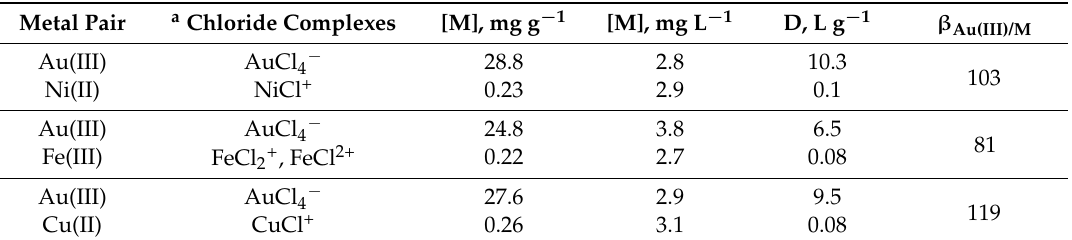
Table 8. Adsorption of gold(III) and base metals from acidic medium and separation factors. Metal